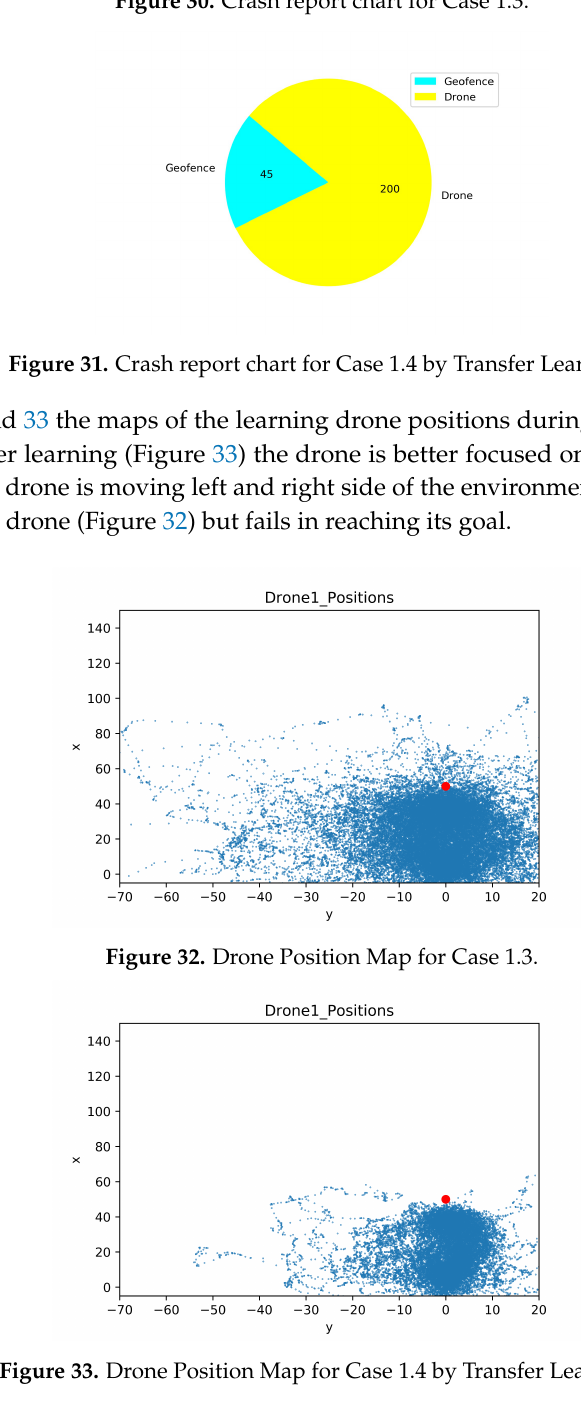
Figure 30. Crash report chart for Case 1.3.